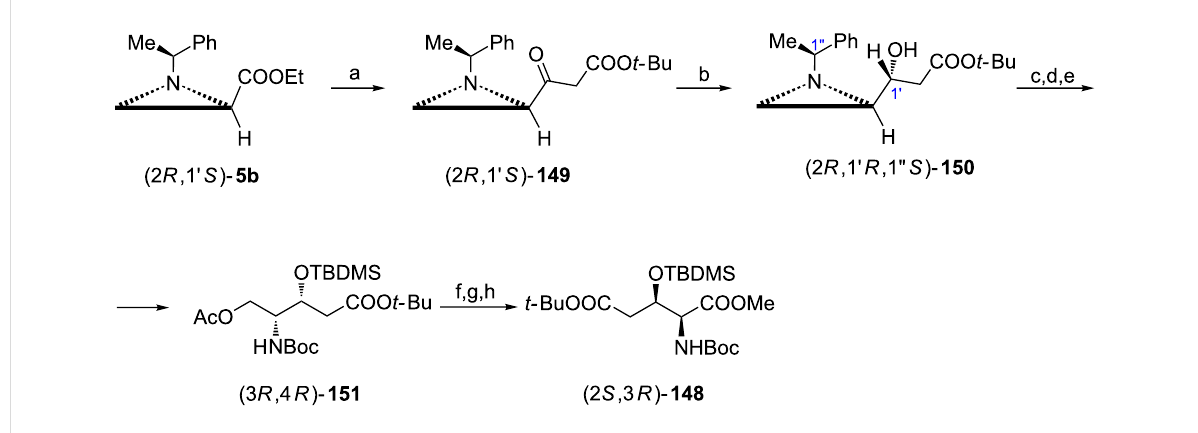
Scheme 38: Synthesis of the protected 3-hydroxy- ʟ -glutamic acid (2 S ,3 R )- 148 . Reagents and conditions: a) LiHMDS, AcO t -Bu, THF, − 78 °C, 0.5 h; b) NaBH